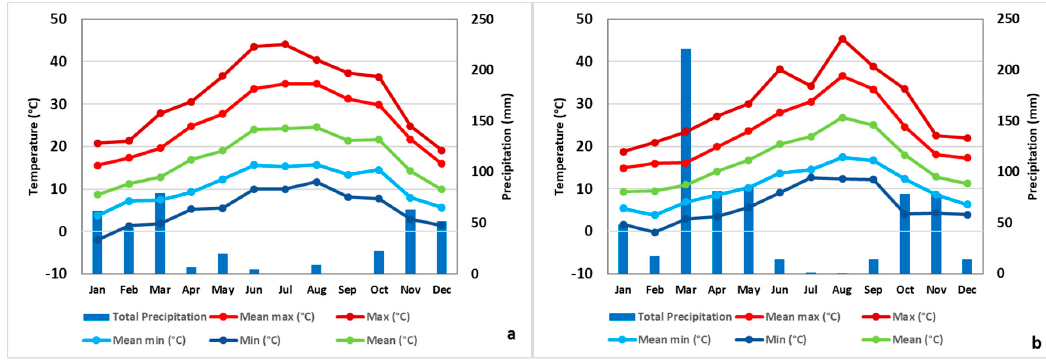
Figure 5. Meteorological conditions at case study II—Alentejo region for ( a ) 2017 and ( b ) 2018.